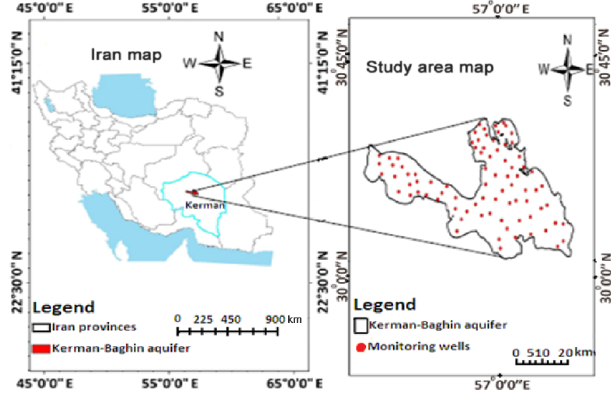
Figure 1. Location map of the Kerman–Baghin